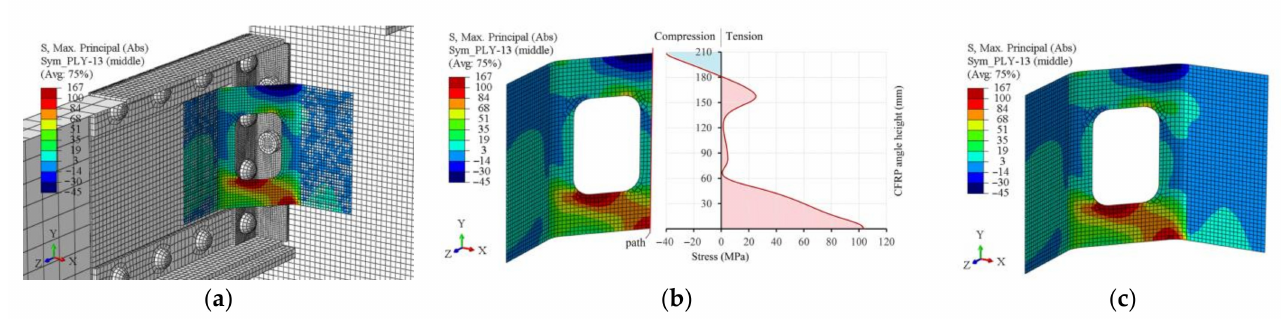
Figure 21. Principal stresses in ply 13 ( 0 ◦ ply at the symmetry plane) of Laminate L3 for bending moment M = 19.50 kN at the